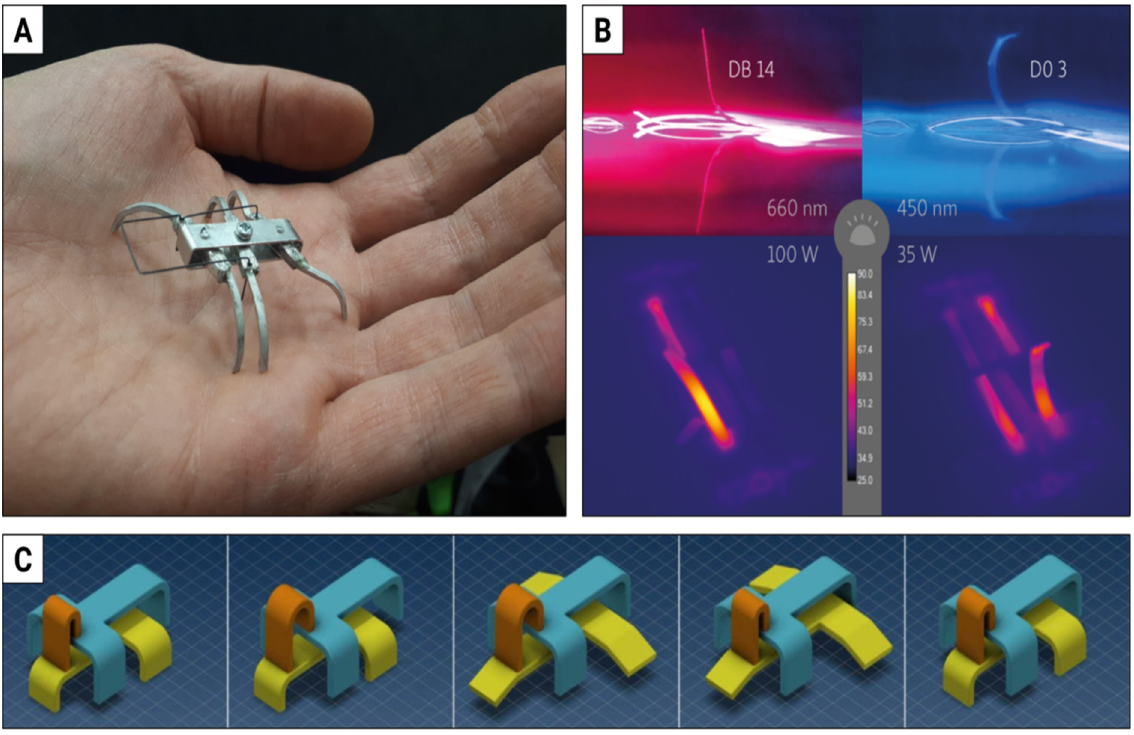
Figure 7. The ultimate walker: LCE ant with two degrees of freedom. ( A ) One of the models built to better understand six-legged locomotion. ( B ) Stripes of LCE with two different dyes, respond by bending to two high-power LEDs with 660 nm and 450 nm centered spectra, respectively. White light (top) and IR (bottom) images. ( C ) One of the concepts of the mechanical design of a six-legged walker with two tripods: one solid (blue) and one with lifting legs (yellow), shifted relative to each other with a bending strip (orange), performing a sequence of deformations that result in a step forward.